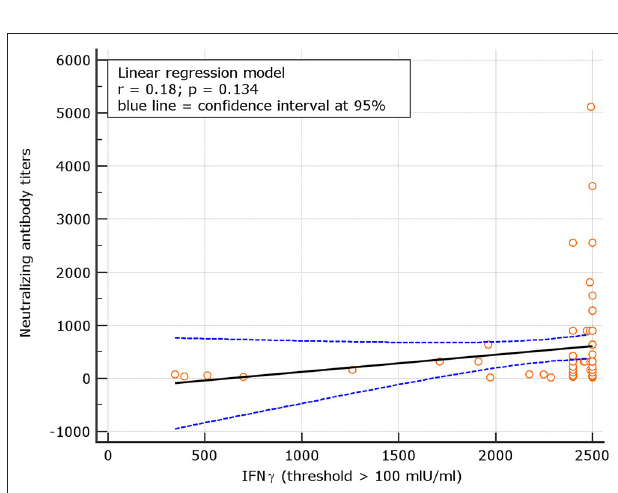
FIGURE 9 | Linear regression model for correlation between neutralizing antibody dilutions and IFN- γ concentration in naive (with IFN- γ concentration > 200 mIU/ml).